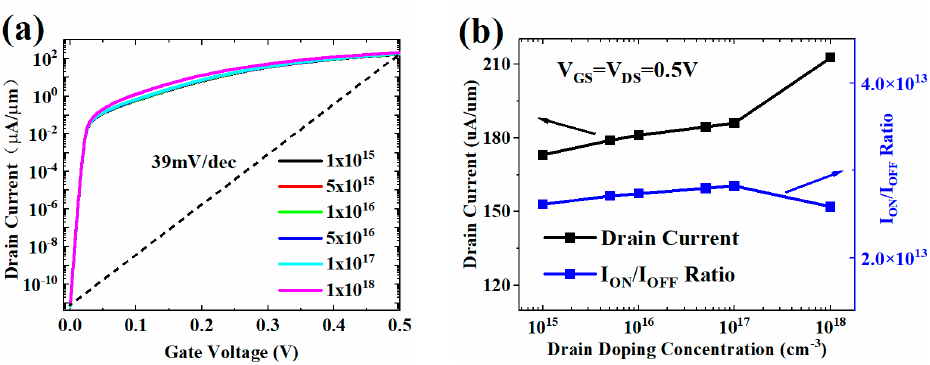
Figure 6. ( a ) Transfer characteristic and ( b ) I ON and I ON /I OFF with different N D values.